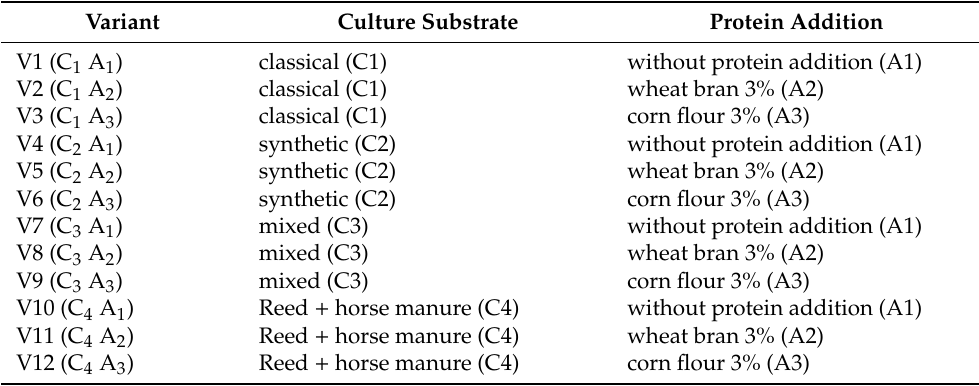
Table A1. Experimental variants of the experimental